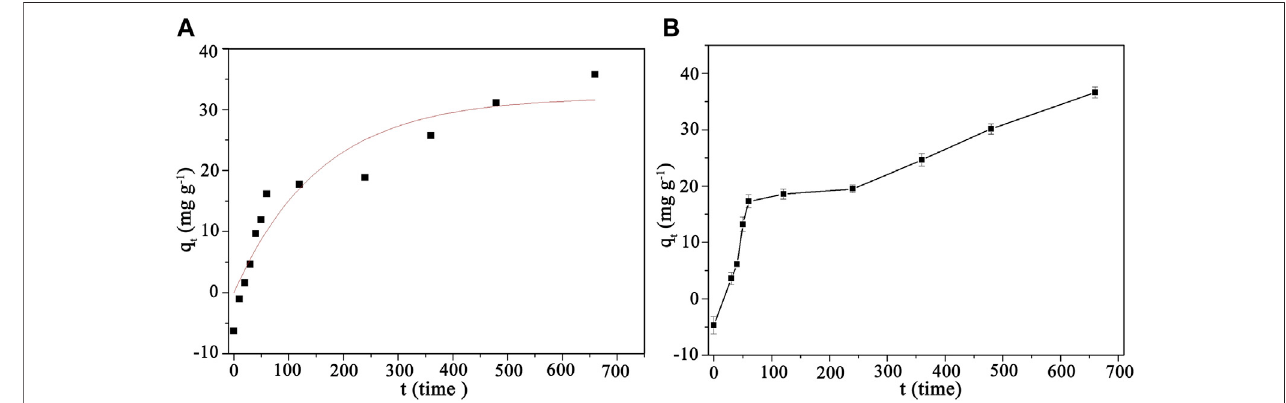
FIGURE 5 | Effect of adsorption time on the adsorption amount of PO 43 − on La 2 (CO 3 ) 3 (A) . Pseudo- fi rst-order kinetic curve of adsorption of PO 43 − on La 2 (CO 3 ) 3 (B) . Initial concentration of PO 43 − : 100 mg L − 1 , temperature: 298.15 K, and pH = 6.8.